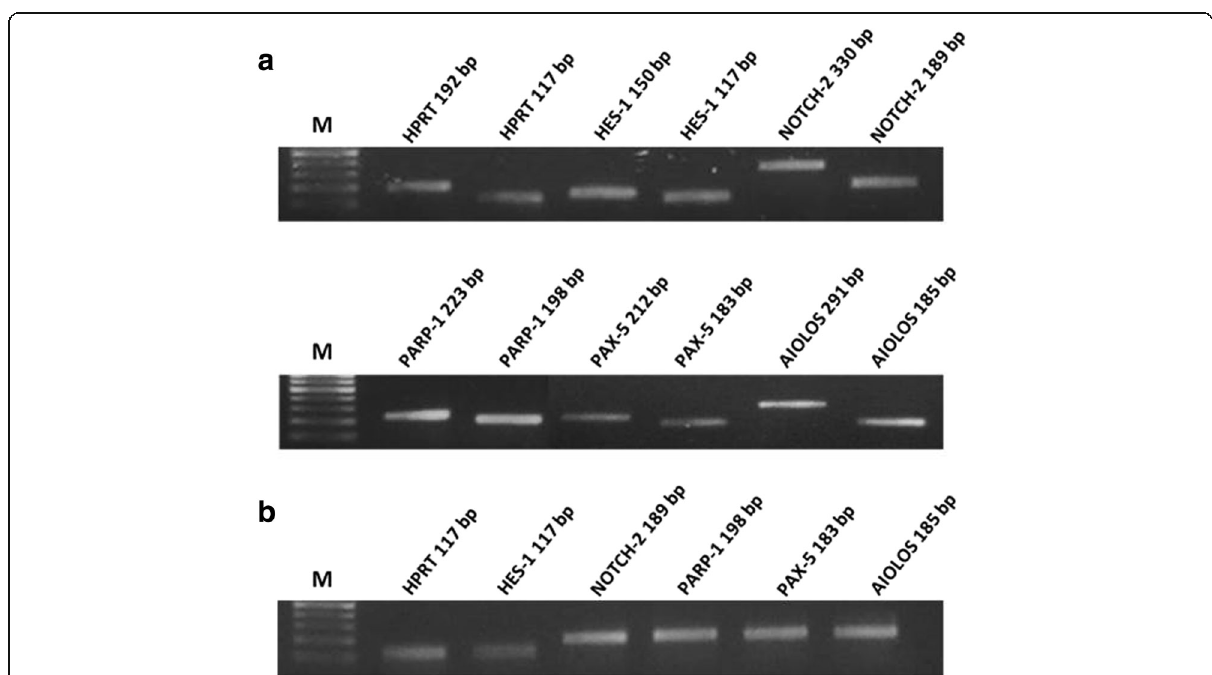
Fig. 1 Validation of primer design strategy. a Efficiency: PCR reactions amplifying cDNA fragments with F1 and F2 semi-nested primers should have the same efficiency. The efficiency of the designed primers was tested on the mixture of all cell line cDNA samples. b Competition: 12 primers present in the same reaction should not interfere with each other. After the first multiplex PCR reaction using the cDNA mixture as a template, separate PCR reactions were set on with semi-nested F2 primers to analyse the specificity of the reaction. M (100 bp DNA Ladder), all amplicons cited with the name of the gene; longer amplicons produced by F1/R and shorter by F2/R primers